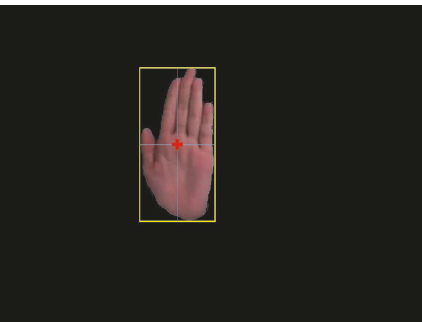
Figure 6: The hand location is represented by the pixel value of the centroid of the segmented hand blob.